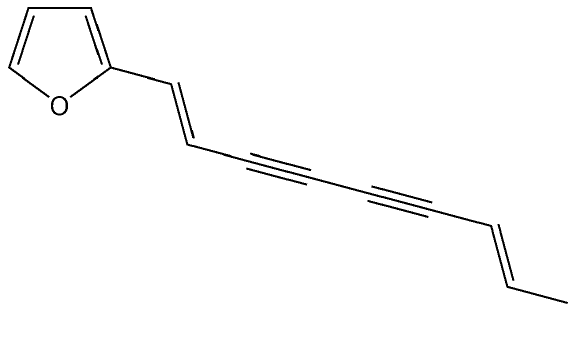
Figure 1. Structure of atractylodin.